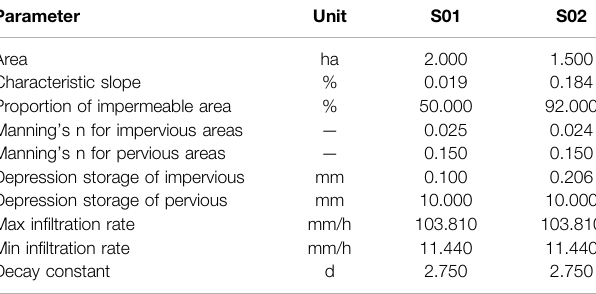
TABLE 1 | Characteristic parameters of sub-catchment S01 and S02. TABLE 2 | Parameters of the permeable pavement (PP) and constructed wetland (CW) in SWMM.